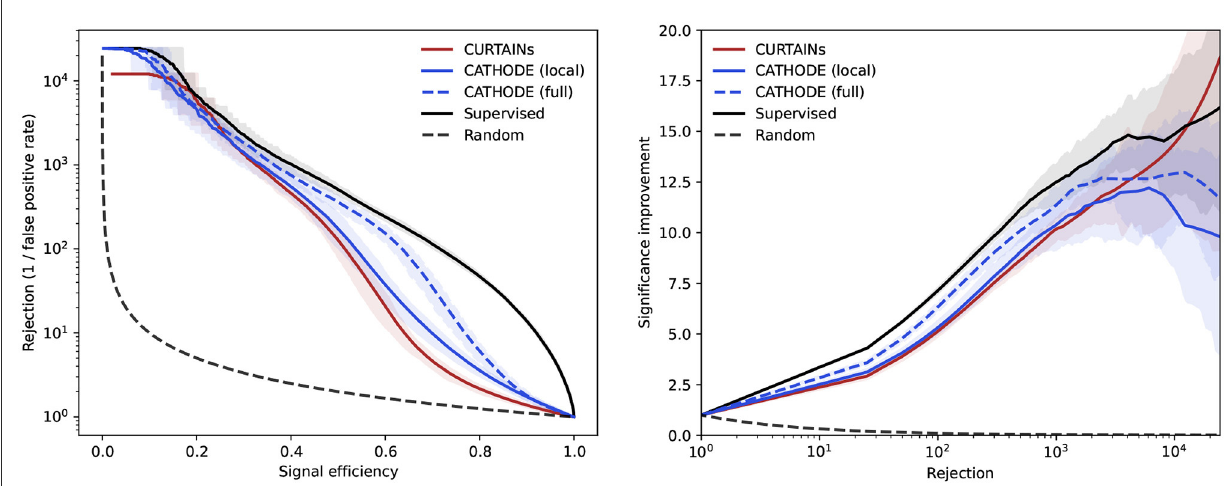
FIGURE8 Background rejection as a function of signal efficiency (left) and signal improvement as a function of background rejection (right) for the C URTAIN s (red), C ATHODE (local) (blue, solid), and C ATHODE (full) (blue, dashed) background template models compared to a supervised classifier (black). The dashed C ATHODE (full) model is trained using all data outside of the signal region, whereas the two solid lines are trained using the default 200 GeV side-bands. All classifiers are trained on the sample with 3,000 injected signal events for the signal region 3,300